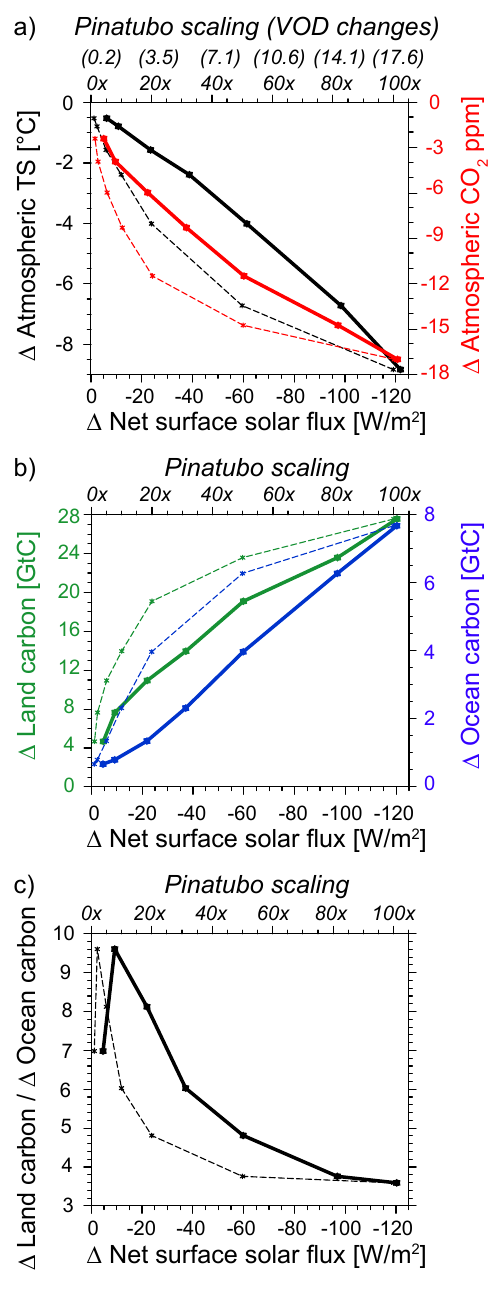
Fig. 2. (a) Peak changes in surface atmospheric temperature (black) and surface atmospheric CO 2 (red) as a function of the Pinatubo scaling (dashed line) and the peak changes in net surface solar flux (solid line), respectively. Aerosol optical depth changes in the mid- visible wavelength (VOD) for the different Pinatubo scalings are also given in brackets (top abscissa). (b, c) The same as in (a) but for (b) land carbon changes (green lines) and ocean carbon changes (blue lines) as well as for (c) the ratio between peak changes in land carbon and ocean